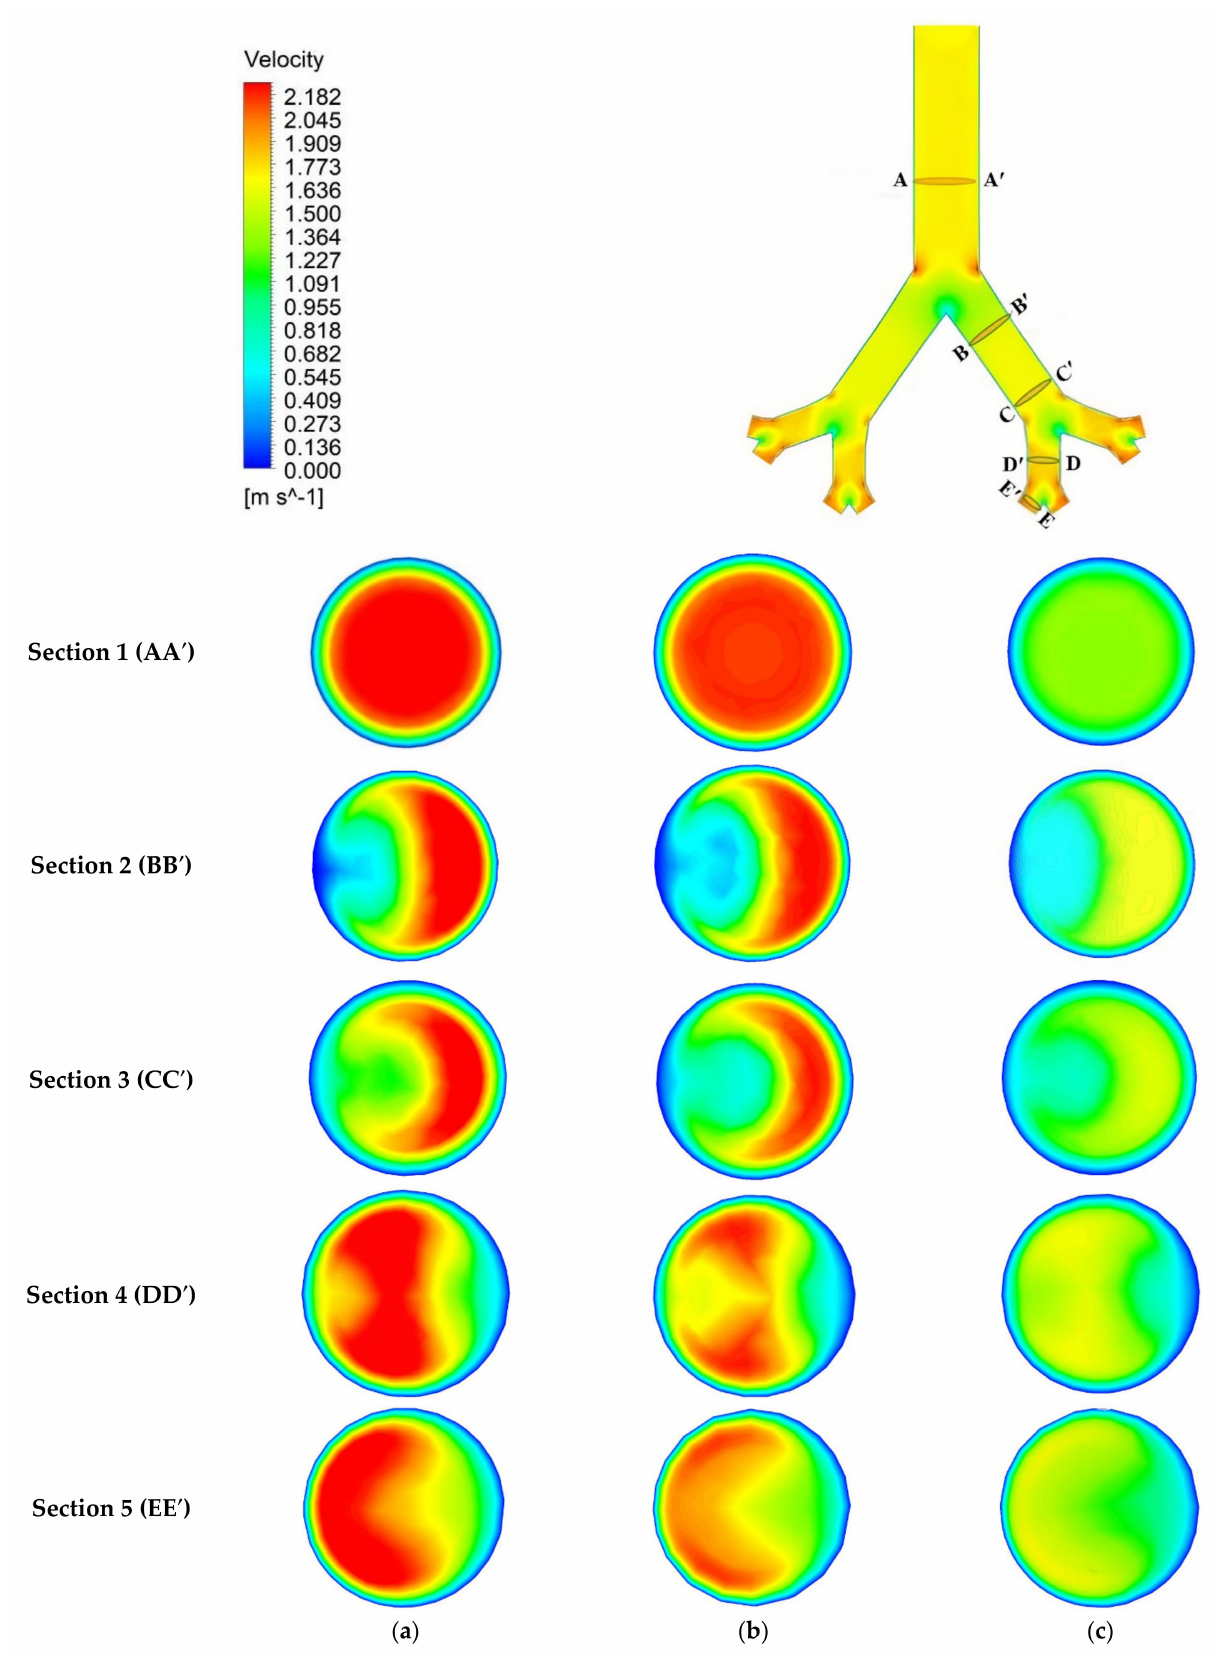
Figure 5. Velocity contours at upper airways generation (G0–G3) defined in the above Figure: ( a ) 9 months, veloc- ity = 1.806 m/s, ( b ) 6 years age, velocity = 1.766 m/s, and ( c ) 30 years age, velocity = 1.071